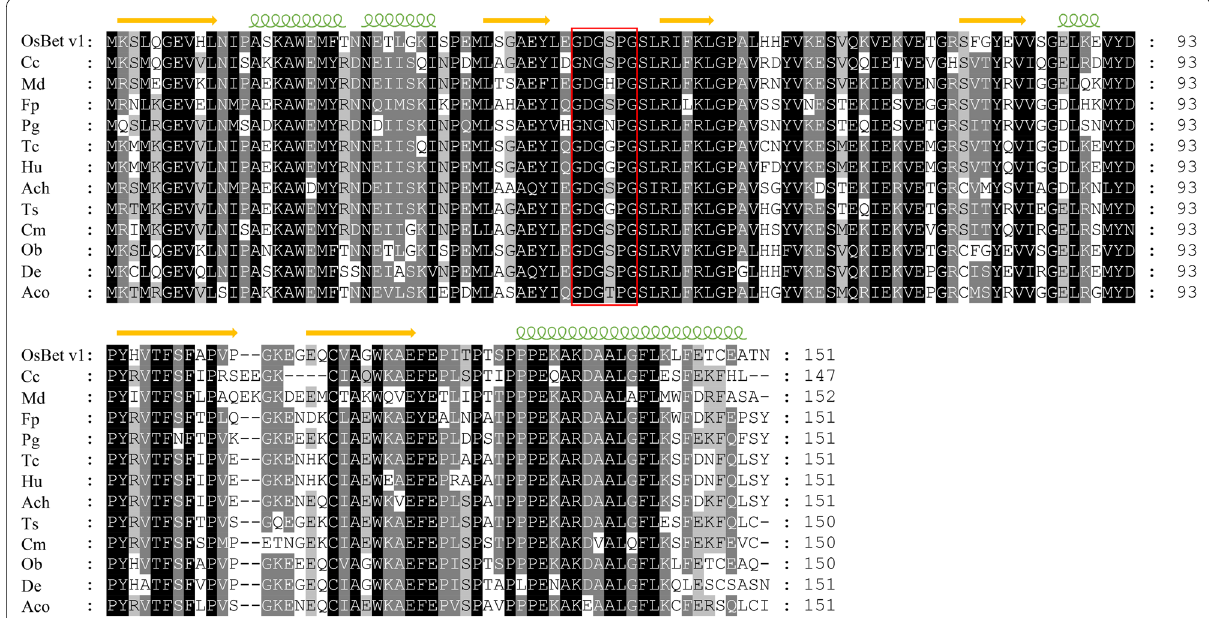
Fig. 1 Multiple sequence alignment of the predicted OsBet v1 protein with some other plant homologous PR10/Bet v1-like proteins. OsBet v1, Oryza sativa (LOC_Os08g28670.1); Fp, Ficus pumila (Q71HN3); De, Digitaria exilis (CAB3482801); Ts, Tetracentron sinense (KAF8409242); Ach, Actinidia chinensis (PSS05718); Cm, Cinnamomum micranthum (RWR89143); Ob, Oryza brachyantha (XP_006659351); Tc, Theobroma cacao (XP_007043599); Aco, Ananas comosus (XP_020105256); Hu, Herrania umbratical (XP_ 021293588); Pg, Punica granatum (OWM78653); Cc, Coptis chinensis (KAF9588434); Md, Malus domestica (RXH90448). The red box indicates the P-loop motif. Green wavy lines and yellow arrows indicate alpha